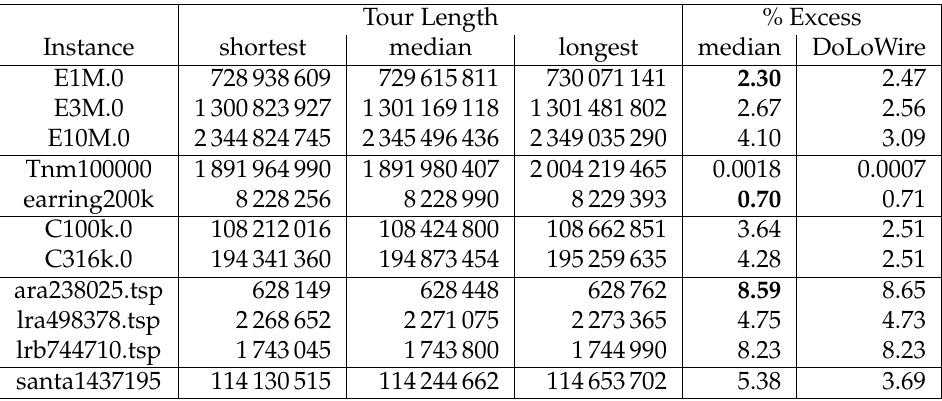
Table 12. Results for different instances after 30 min of processing for Sys2to6 in combination with GrebCap+. Results in bold face are better than Sys2to6 in combination with DoLoWire.